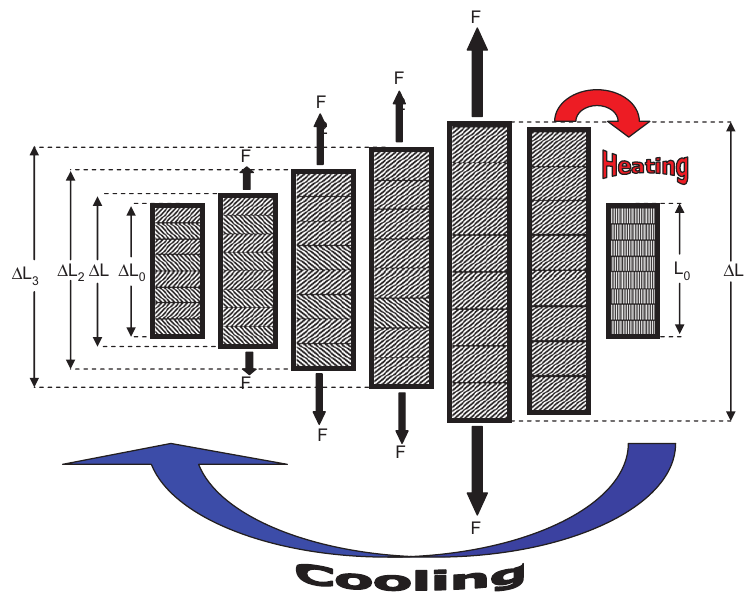
This defines the natural state of the body that has an original length of L . The application of a tensile load will 0 subject the layers to a shear load. As seen in Figure 12, the M layers become flatter while the M layers will become + - Δ i steeper. The vertical component of the shear lengths, 2 (summed over all N layers) will provide the total deforma- tion of the body and is given by